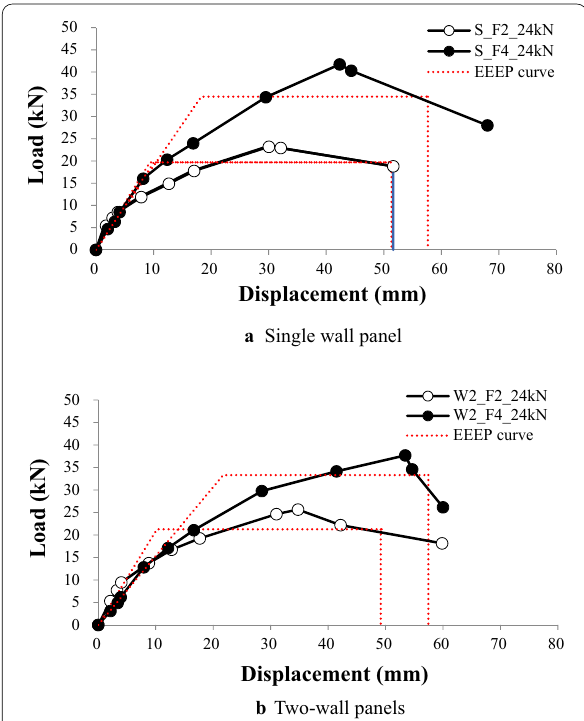
Fig. 9 Load–displacement curves depending on the number of wall‑to‑floor connectors